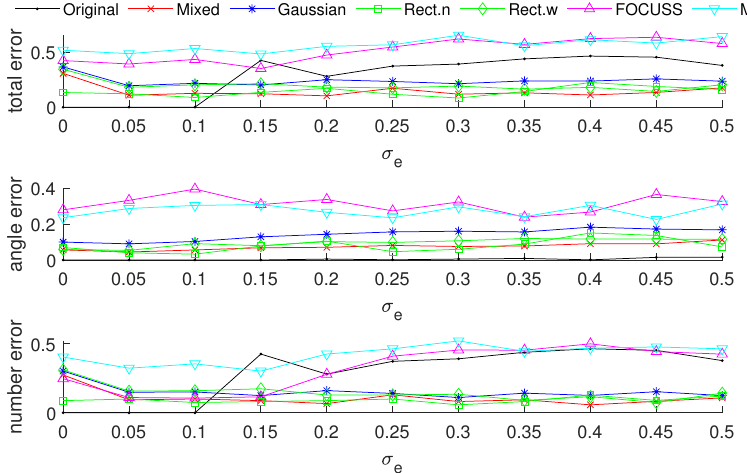
Figure 9. The DOA estimation error in terms of OSPA distance with the prior distribution given by N ( 500,50 2 ) and N ( 1500,50 2 ) when the true distributions are given by N ( 500,100 2 ) and N ( 1500,100 2 ) .